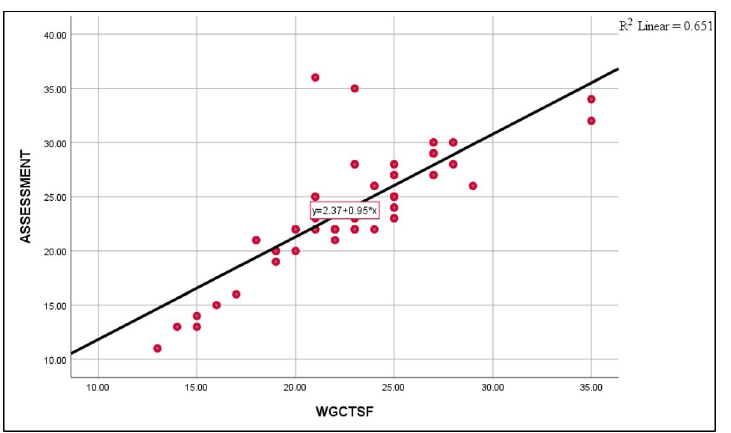
Fig 1. Watson-Glaser critical thinking short-form and the two questions